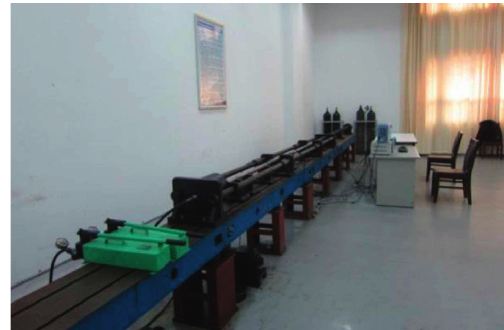
Figure 2: SHPB test